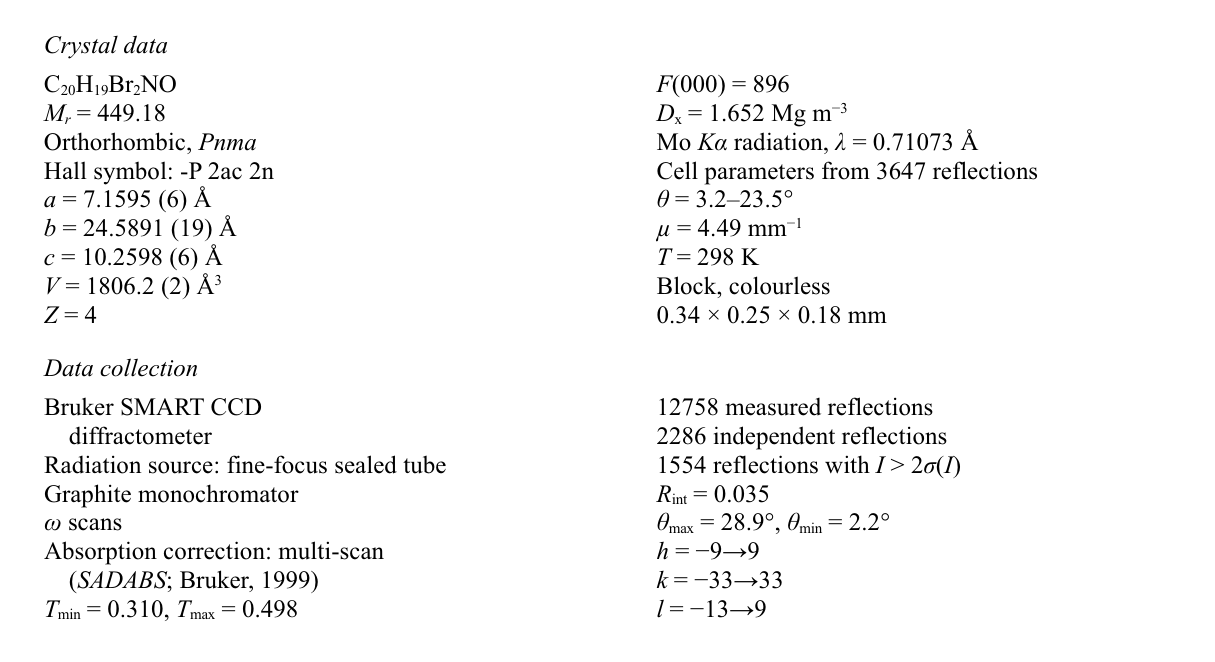
Figure 2 Packing diagram with N—H···O (blue) and C—H···O (red) interactions.